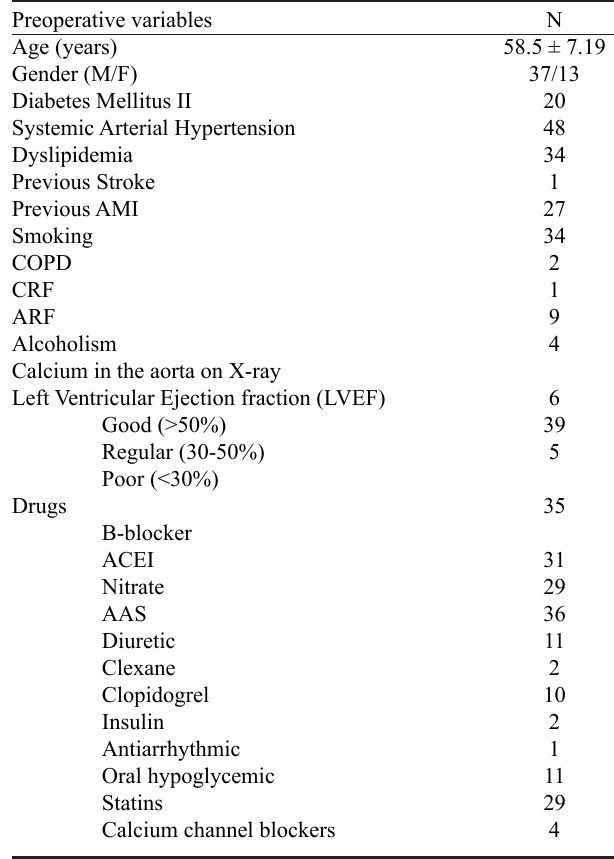
Table 1. Patient's